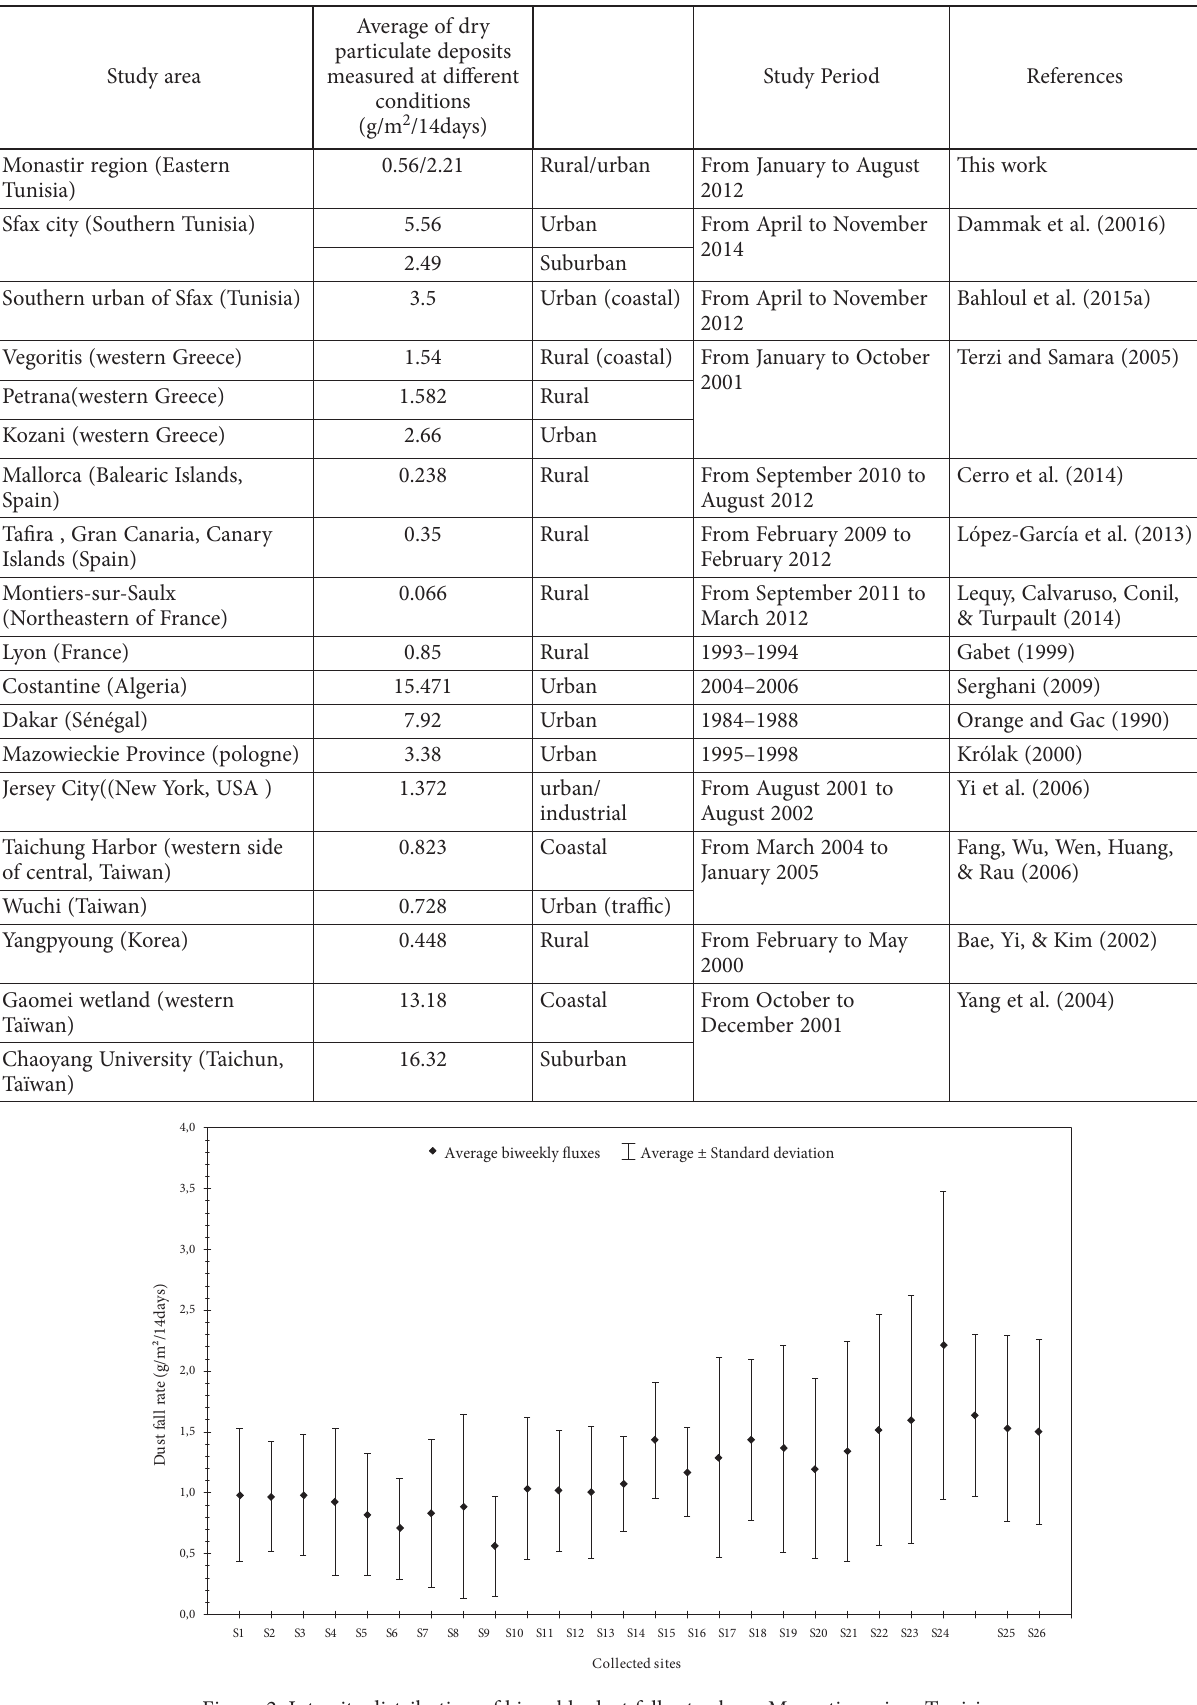
Figure 2. Intersite distribution of biweekly dust fall rate above Monastir region,